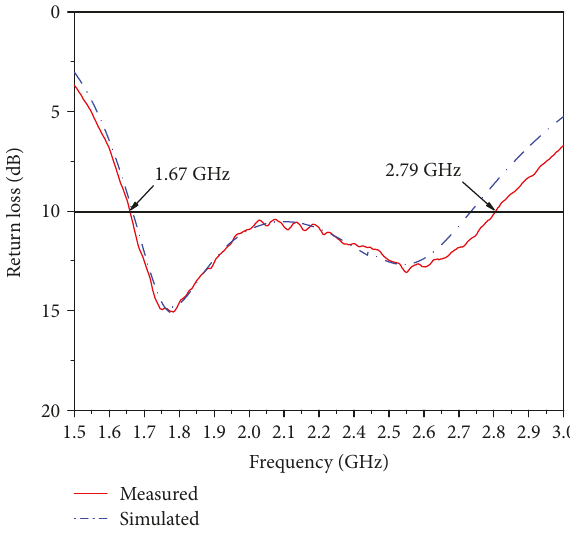
Figure 7: Measured and simulated return loss of the wideband HP quasi-omnidirectional